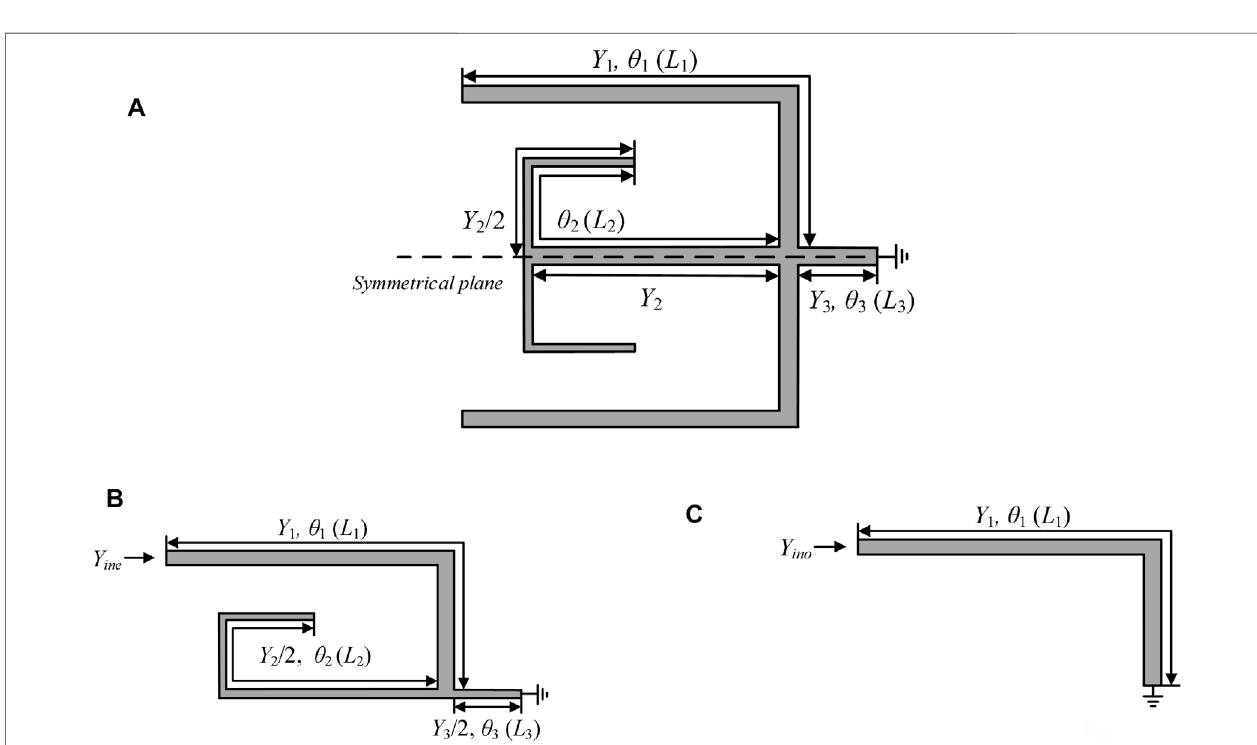
FIGURE 2 | Structure of triple-mode resonator and even-/odd-mode. (A) Entire resonator. (B) Even-mode equivalent circuit. (C) Odd-mode equivalent circuit.